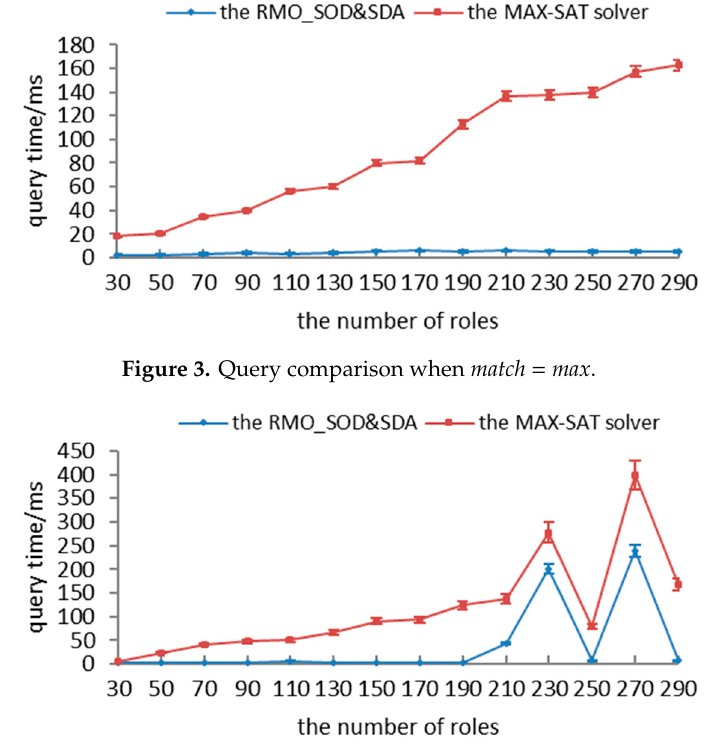
Table 15. Comparison of execution time.